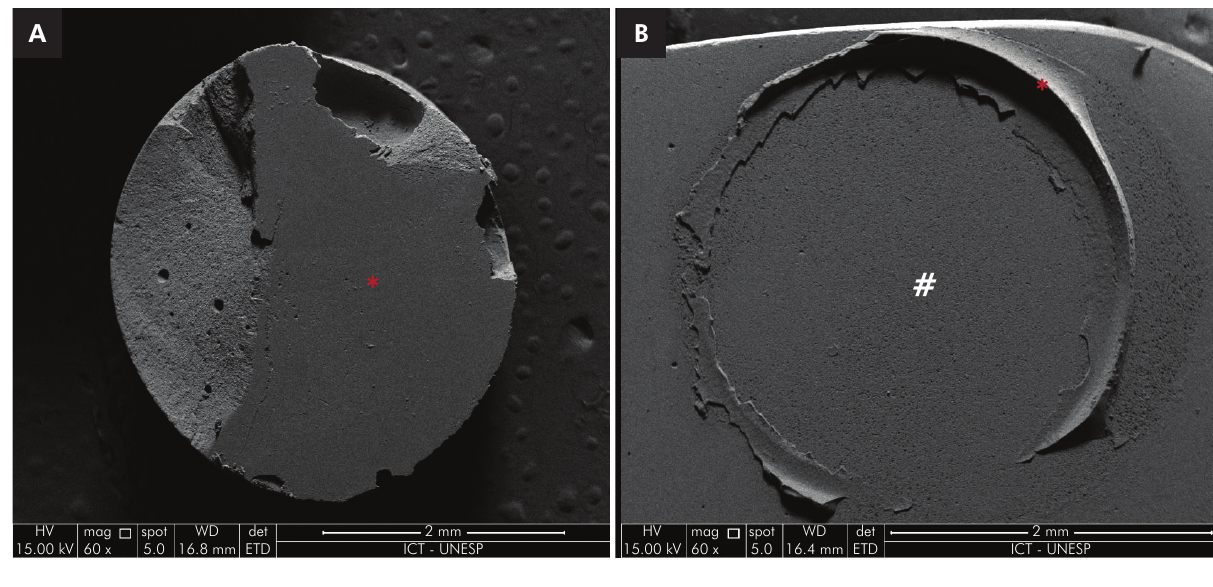
Figure 3. SEM (60x) micrographs of cohesive in ceramic (A) and mixed (A and B) failures. Ceramic (*), resin cement